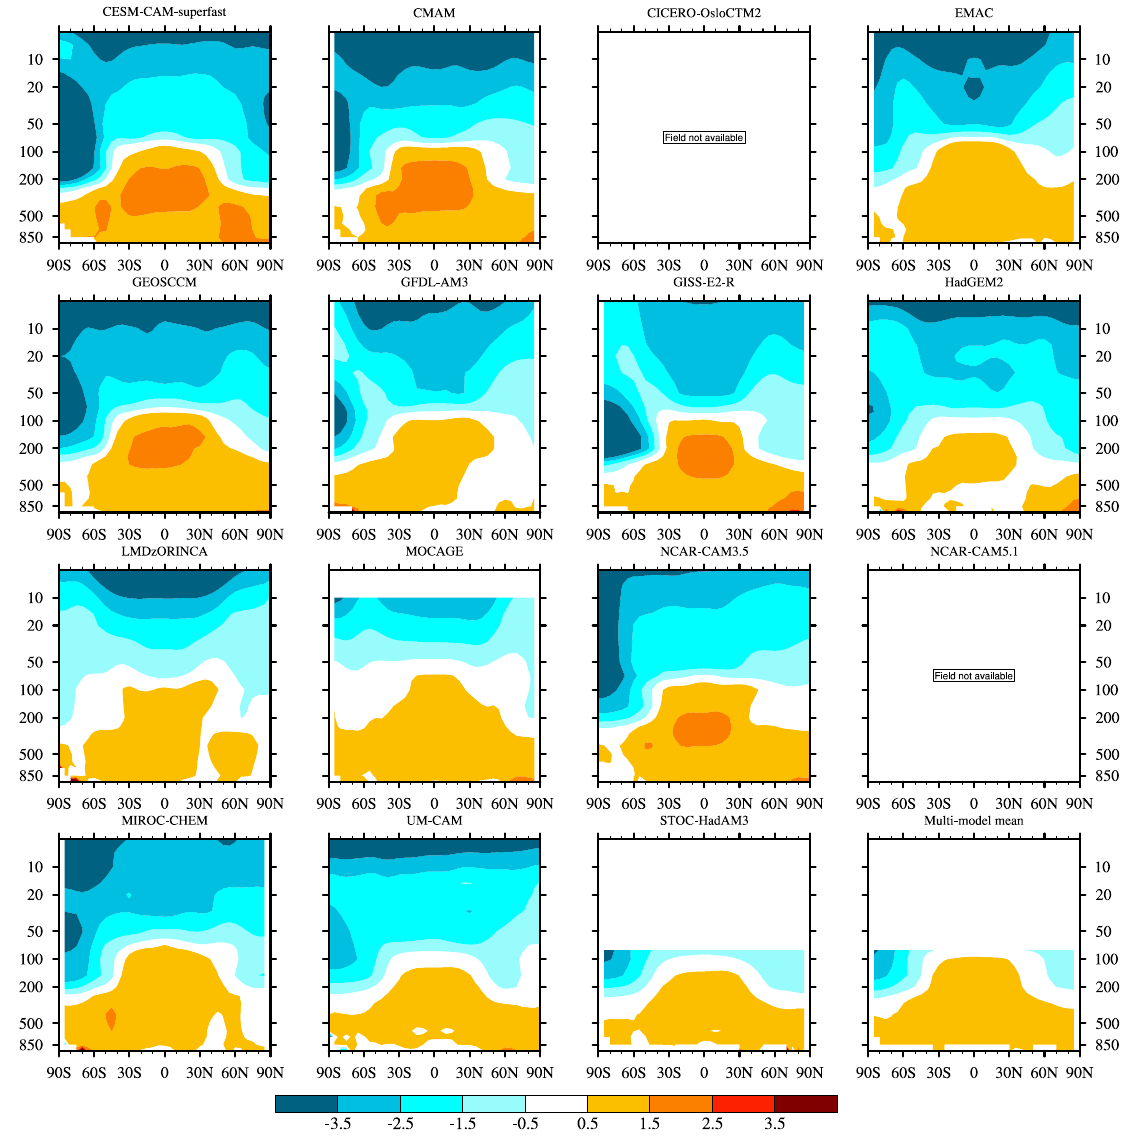
Figure 11a. Difference 2000-­‐1850 in annual and zonal mean temperature (K). Fig. 11a. Difference 2000–1850 in annual and zonal mean temperature (K). Fig. 11a. Difference 2000–1850 in annual and zonal mean temperature